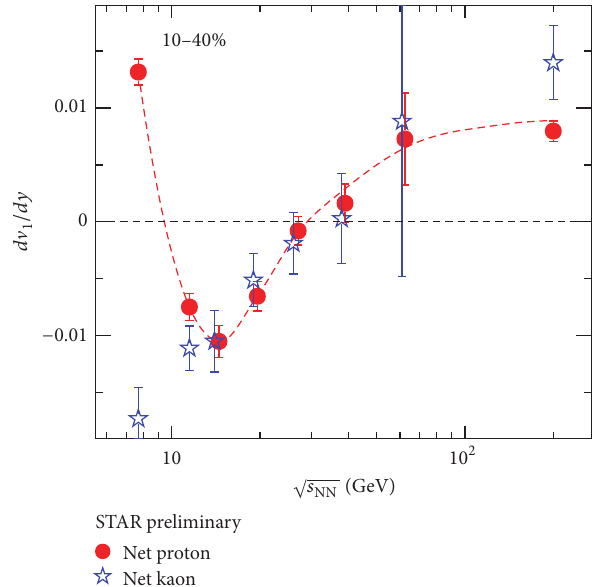
Figure 12: Beam energy dependence of the slope of V 1 (𝑦) for net protons and net kaons in 10–40% centrality Au+Au collisions, as reported by STAR [47,